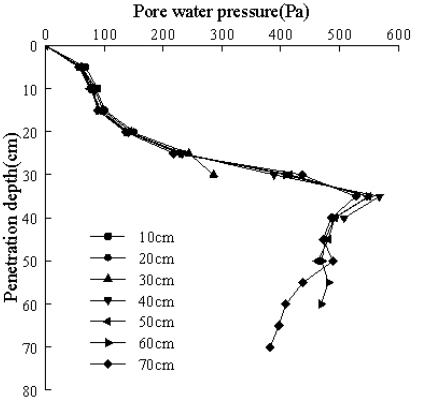
Figure 10. Relationship between the pore water pressure and penetration depth at di ff erent pile pressing depths.